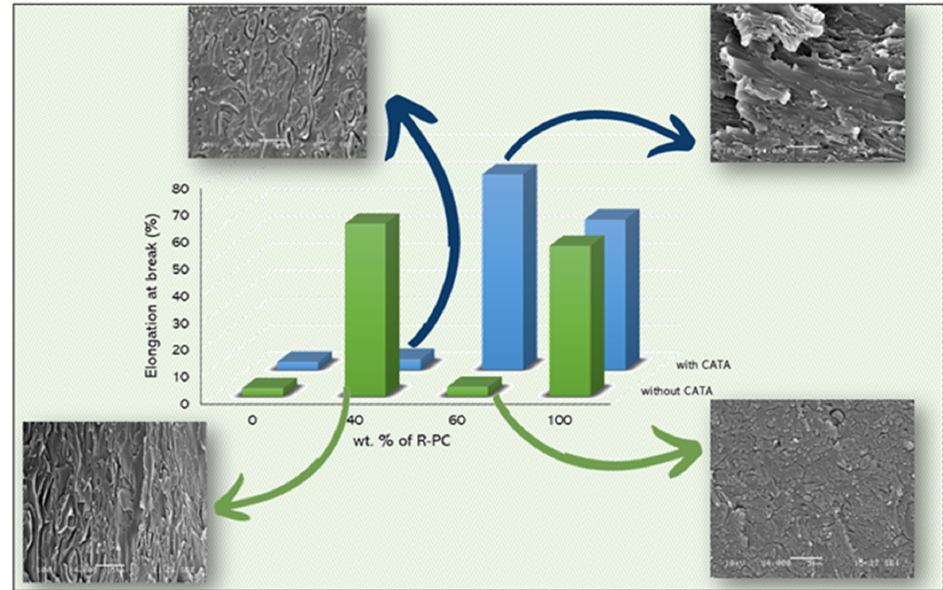
Figure 8 . Morphology/elongation at break relationship . Figure 8. Morphology/elongation at break relationship.